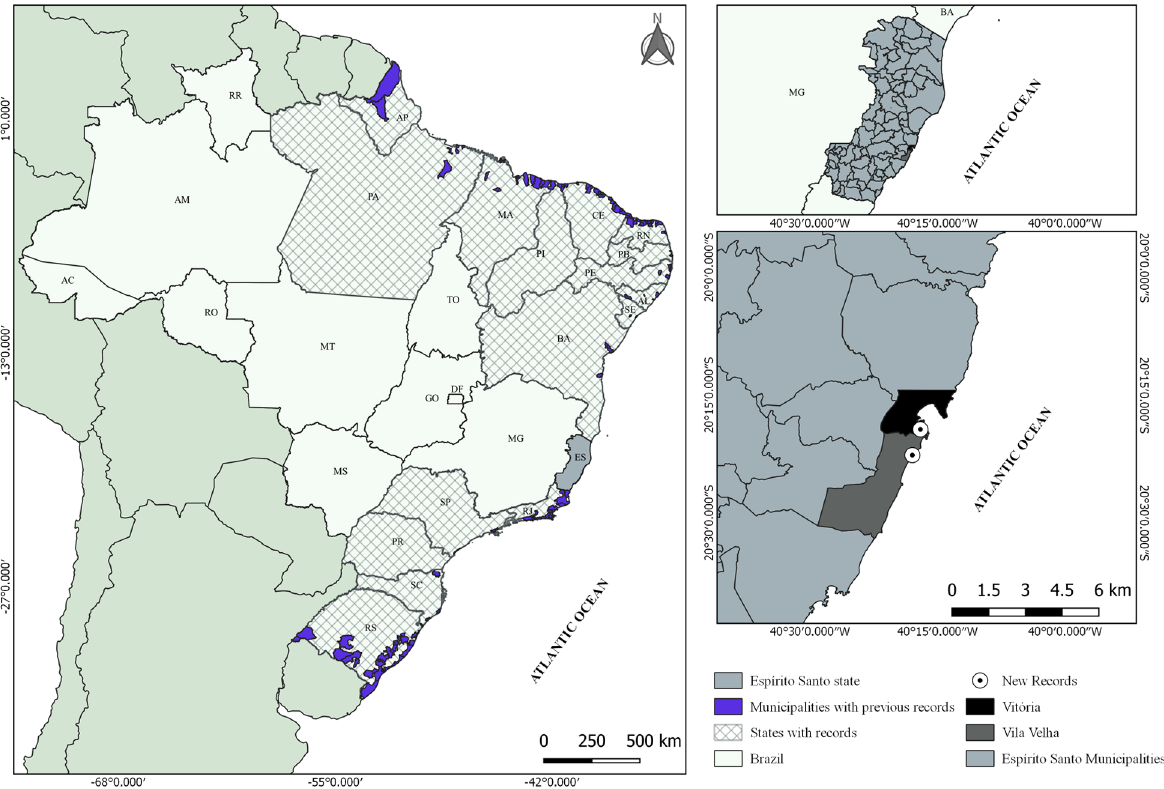
Figure 1. Distribution map of the Gray-hooded Gull, Chroicocephalus cirrocephalus (Vieillot, 1818), in Brazil. Left: municipalities with previ- ous records cited in the scientific literature and online databases: eBird, GBIF, iNaturalist, speciesLink and WikiAves. Right: municipalities and specific sites where the two new records were registered in the state of Espírito